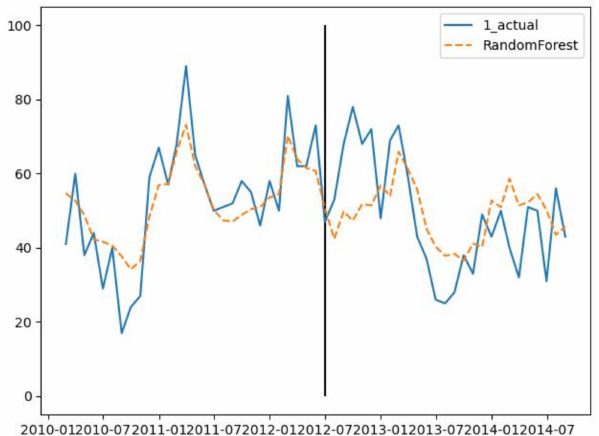
Figure 8. Random forest’s fitting and prediction results for group